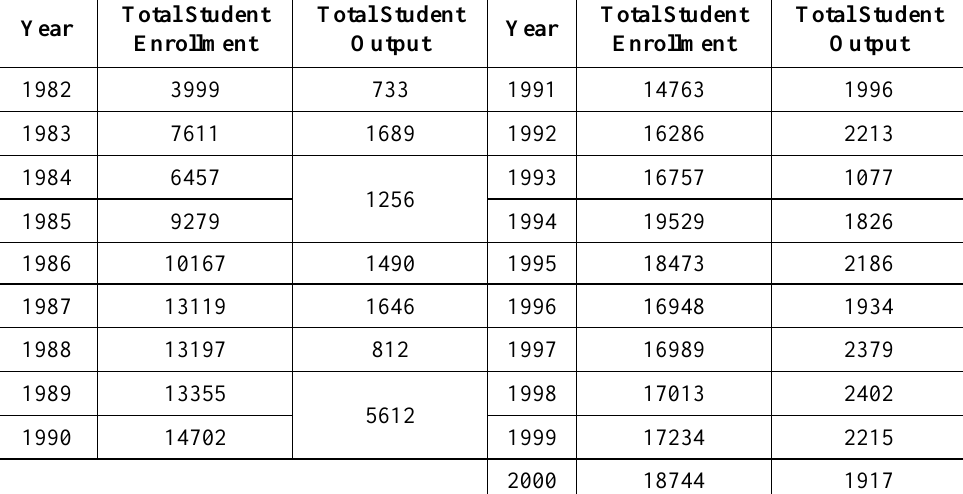
Table 01: Total Student Enrollment and Output from Year